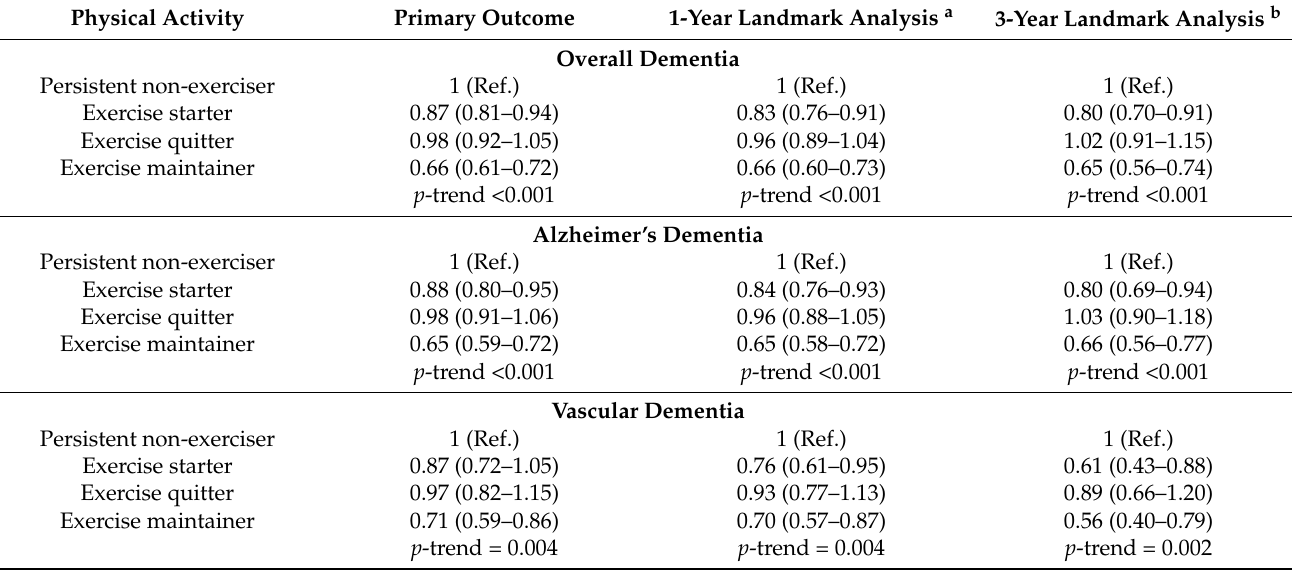
Table 2. The landmark analysis of one-year and three-year compared with the primary